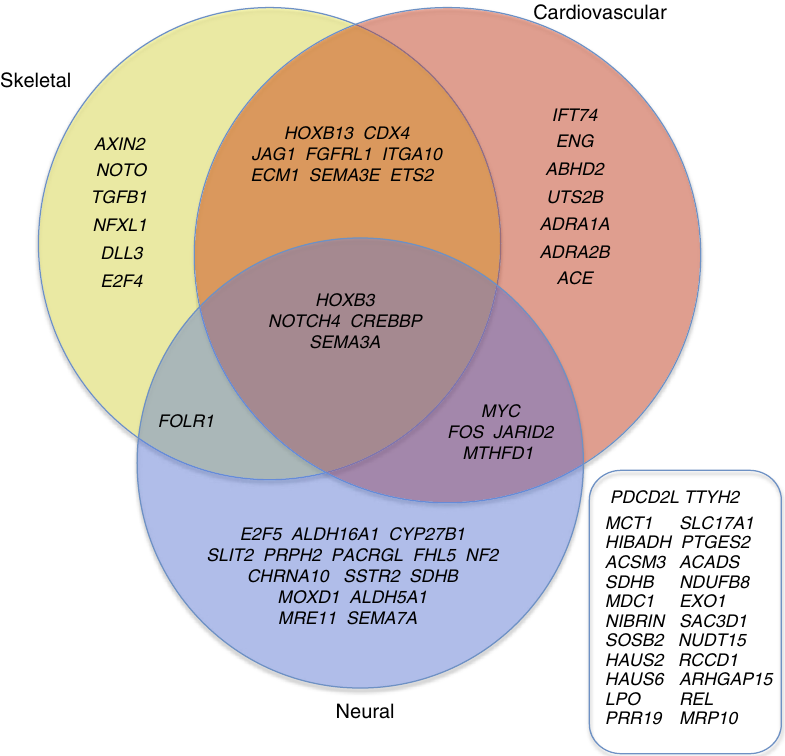
Figure 4 | Gene cluster analysis of genes that exhibit evidence of adaptive evolution in giraffe. Developmental and physiological regulatory genes in giraffe that exhibit adaptive evolution are enriched in skeletal, cardiovascular and neural functions. The MSA genes that are not known to be related to the regulation of skeletal, cardiovascular, or neural development are listed (right